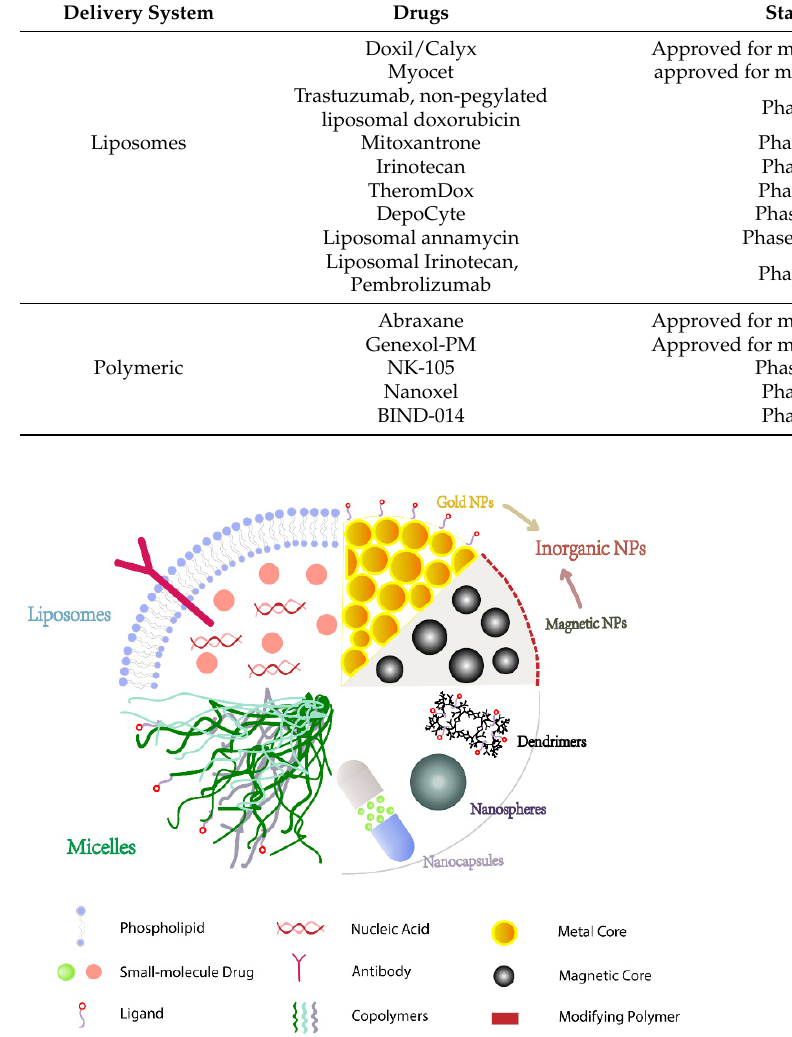
Figure 2. Nanoparticles with varying characteristics in targeting drug delivery